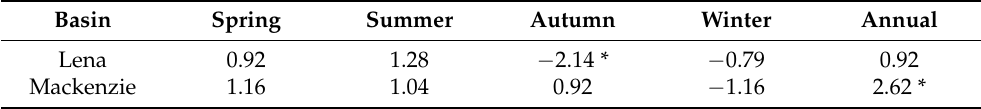
Figure 3. Variations in the annual and seasonal ET in the MRB and LRB calculated by GLEAM during 2003–2016. ( a ) annual ET; ( b ) seasonal ET. Table 2. The results of the TFPW-MK test for the ET in Lena and Mackenzie. Values exceeding 1.96 represent the upward significant trends, whereas those less than 1.96 represent decreasing trends at α < 0.05. Basin